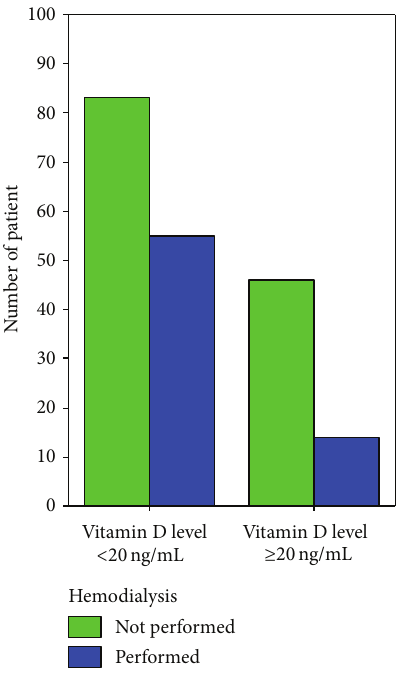
Figure 9: Performing hemodialysis during ICU stay in vitamin D insufficient and sufficient patients (𝑃 = 0.025) .